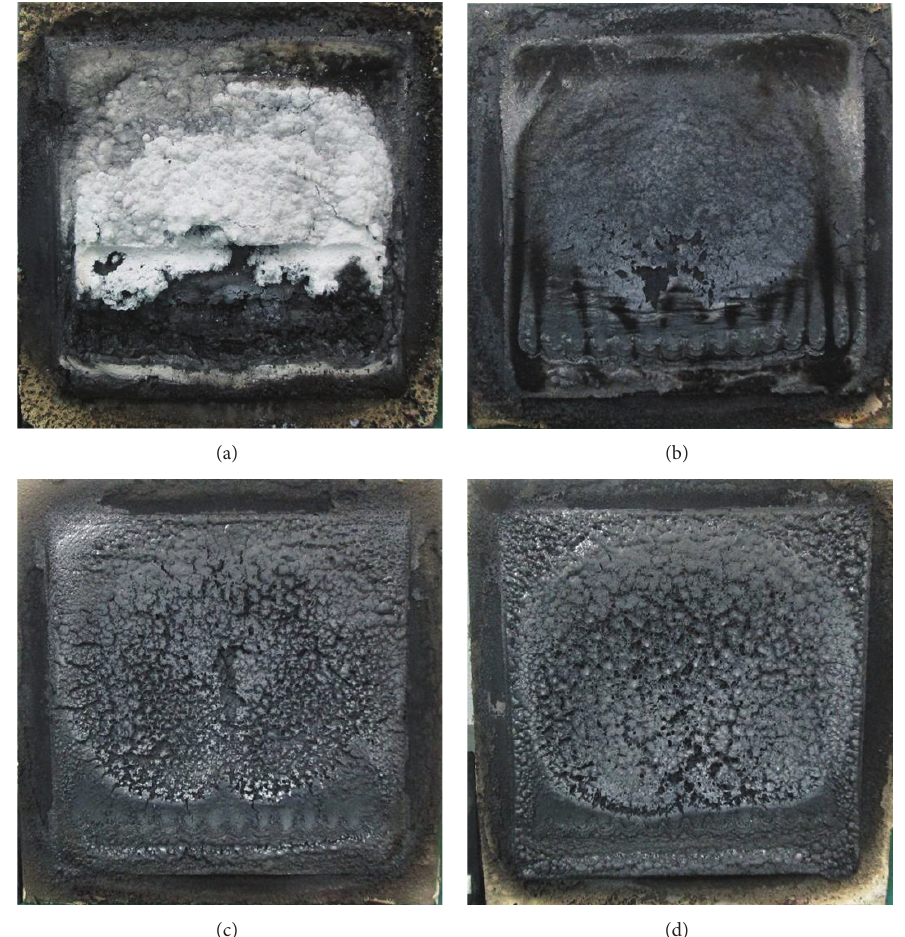
Figure 2: Tested samples (a) A, (b) B, (c) C, and (d) D according to BS 476: Part 6-Fire propagation